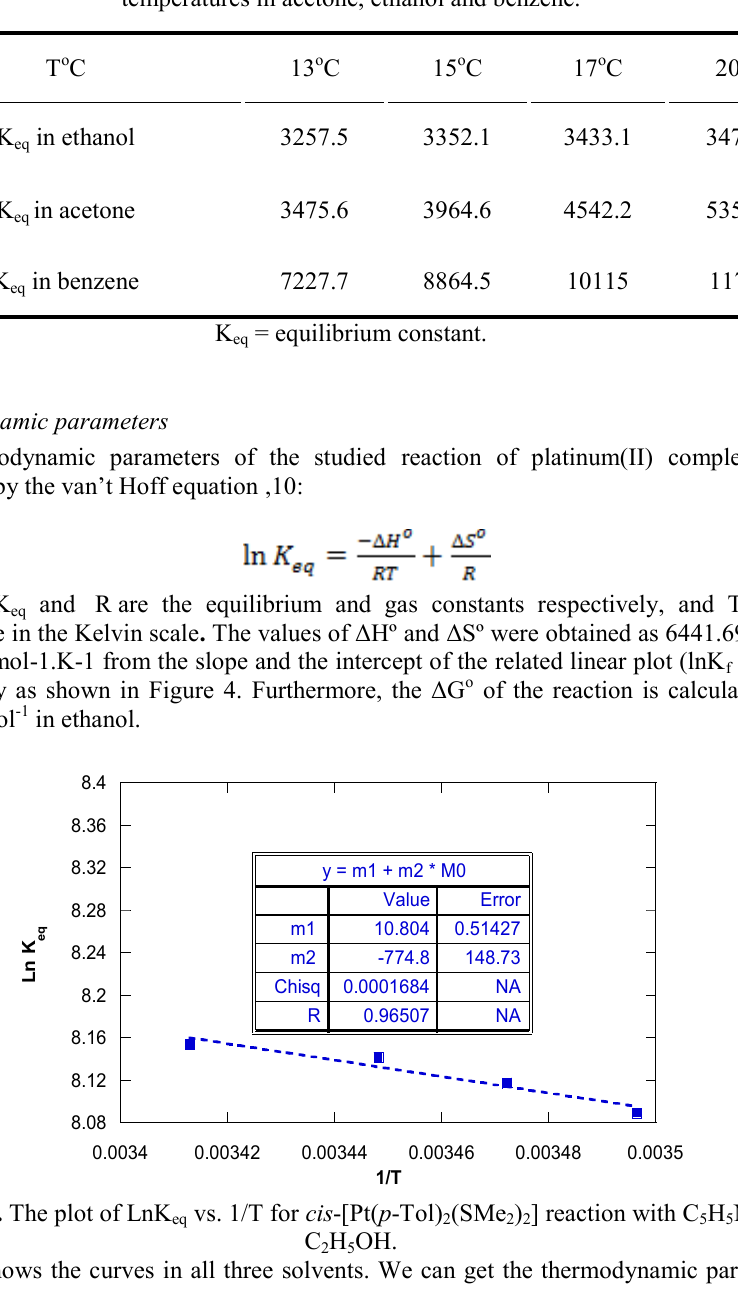
(SMe ) ] with various C 2 2 2